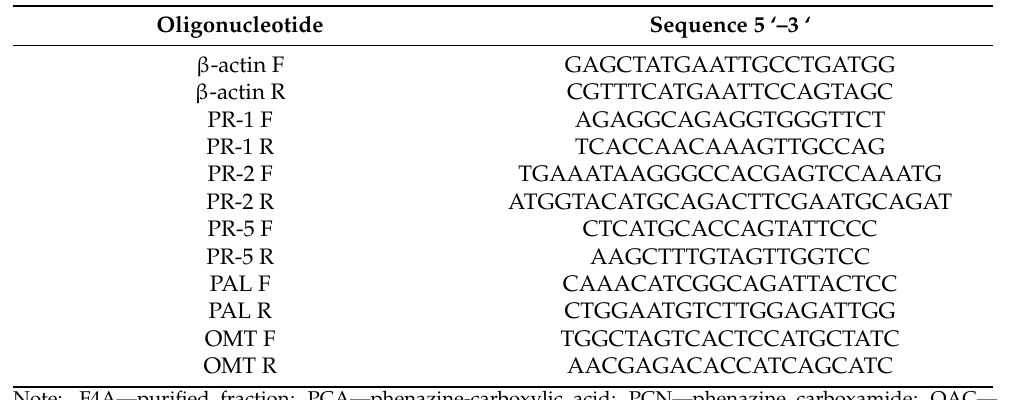
Table 1. Oligonucleotides used in qPCR analyses.